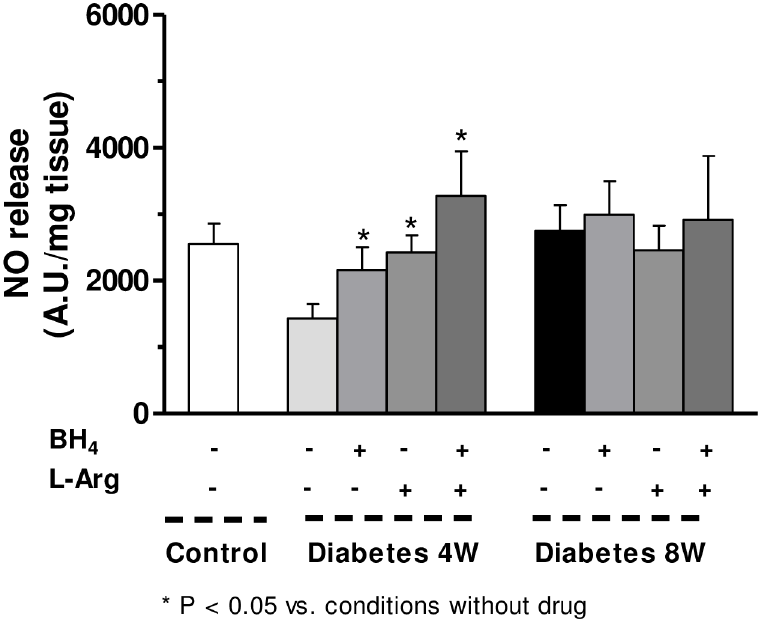
Fig 3. Effect of preincubation with L-arginine, BH4 or L-arginine plus BH4 on the EFS-induced nitric oxide release in mesenteric segments from four- (4W) and eight-week (8W) diabetic rats. Results (mean ± SEM) are expressed as arbitrary (A.U.) (cid:1) mg − 1 tissue. Two way ANOVA, * P < 0.05 vs . without L- arginine or